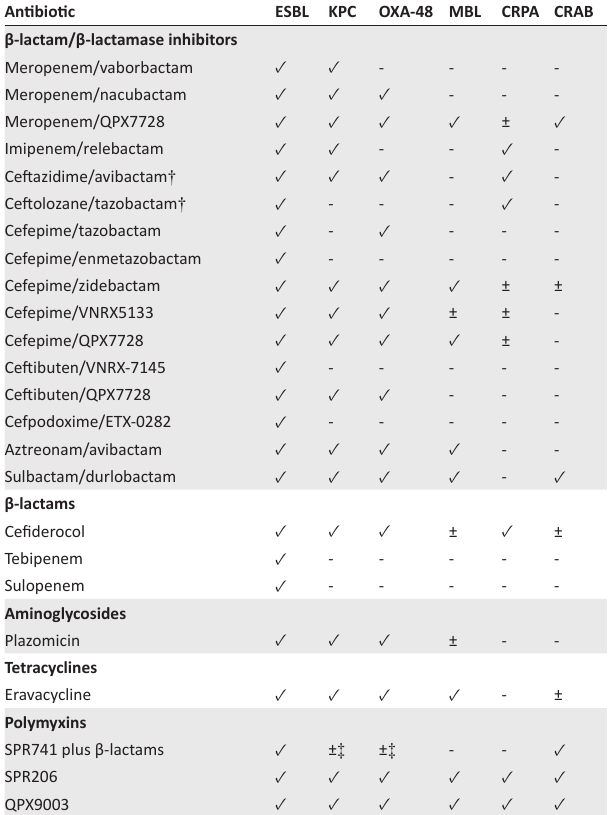
TABLE 1: List of the new agents for difficult-to-treat resistant Gram-negatives. †